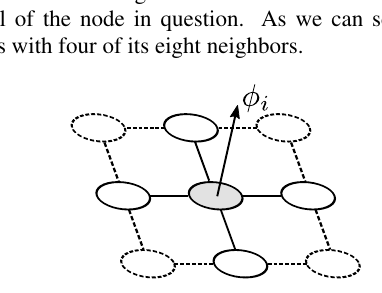
Figure 1. Connection between a central node and its four neighbors. The nodes with solid lines are those that connect to the central node and the edges in solid line indicate these connections. The arrow indicates the unary potential φ i of the central